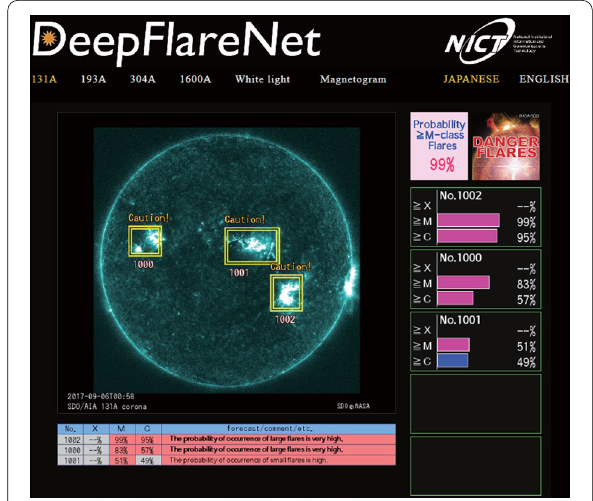
Fig. 3 Website of operational DeFN showing a full-disk solar image and detected ARs, in addition to the full-disk forecasts, region-by-region forecasts, an alert mark, and a comment list (https:// defn. nict. go.